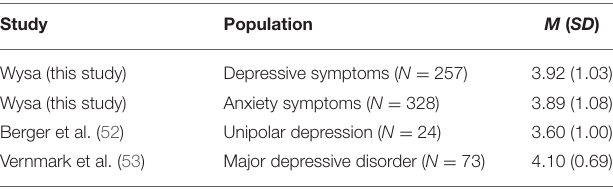
TABLE 4 | Comparison of Working Alliance Inventory-Short Revised bond subscale scores across clinical populations.